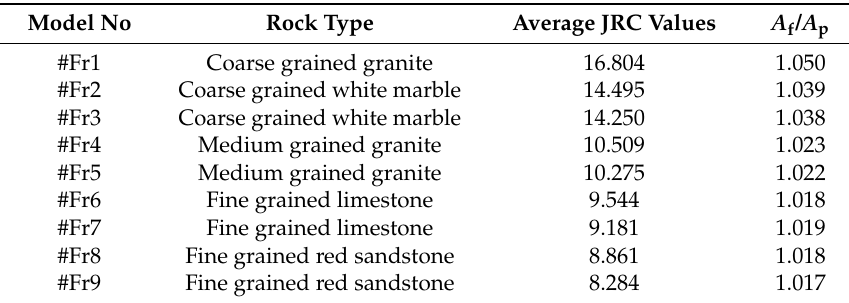
Table 1. Rough characteristics of the tested model fractures.